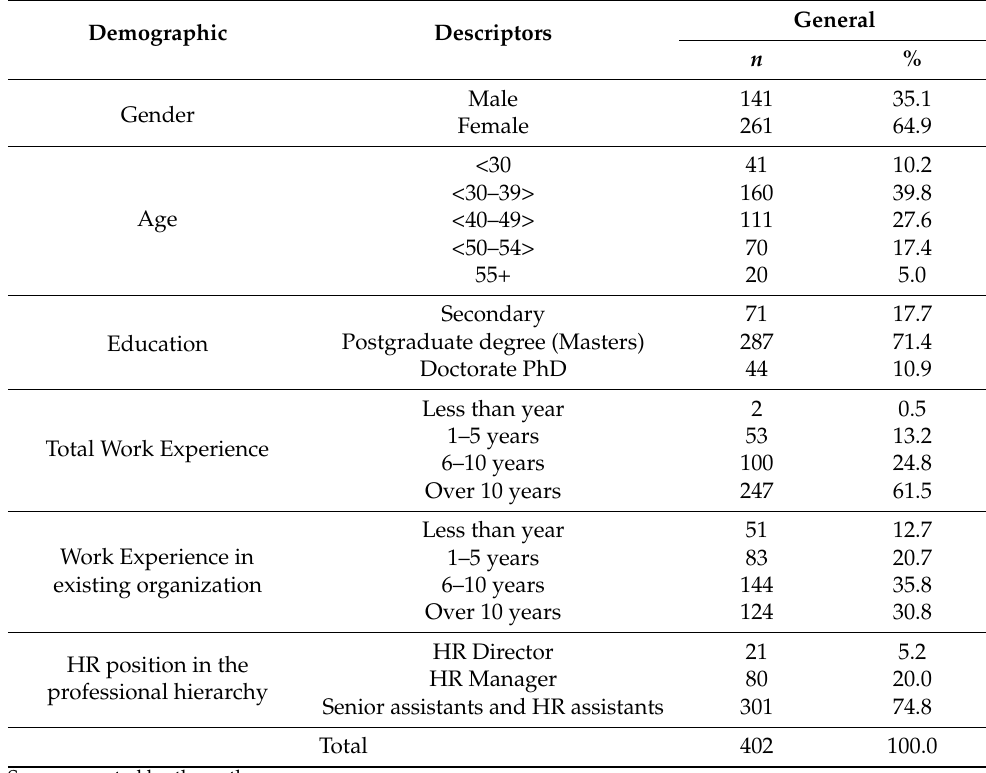
Table 1. Demographic description of